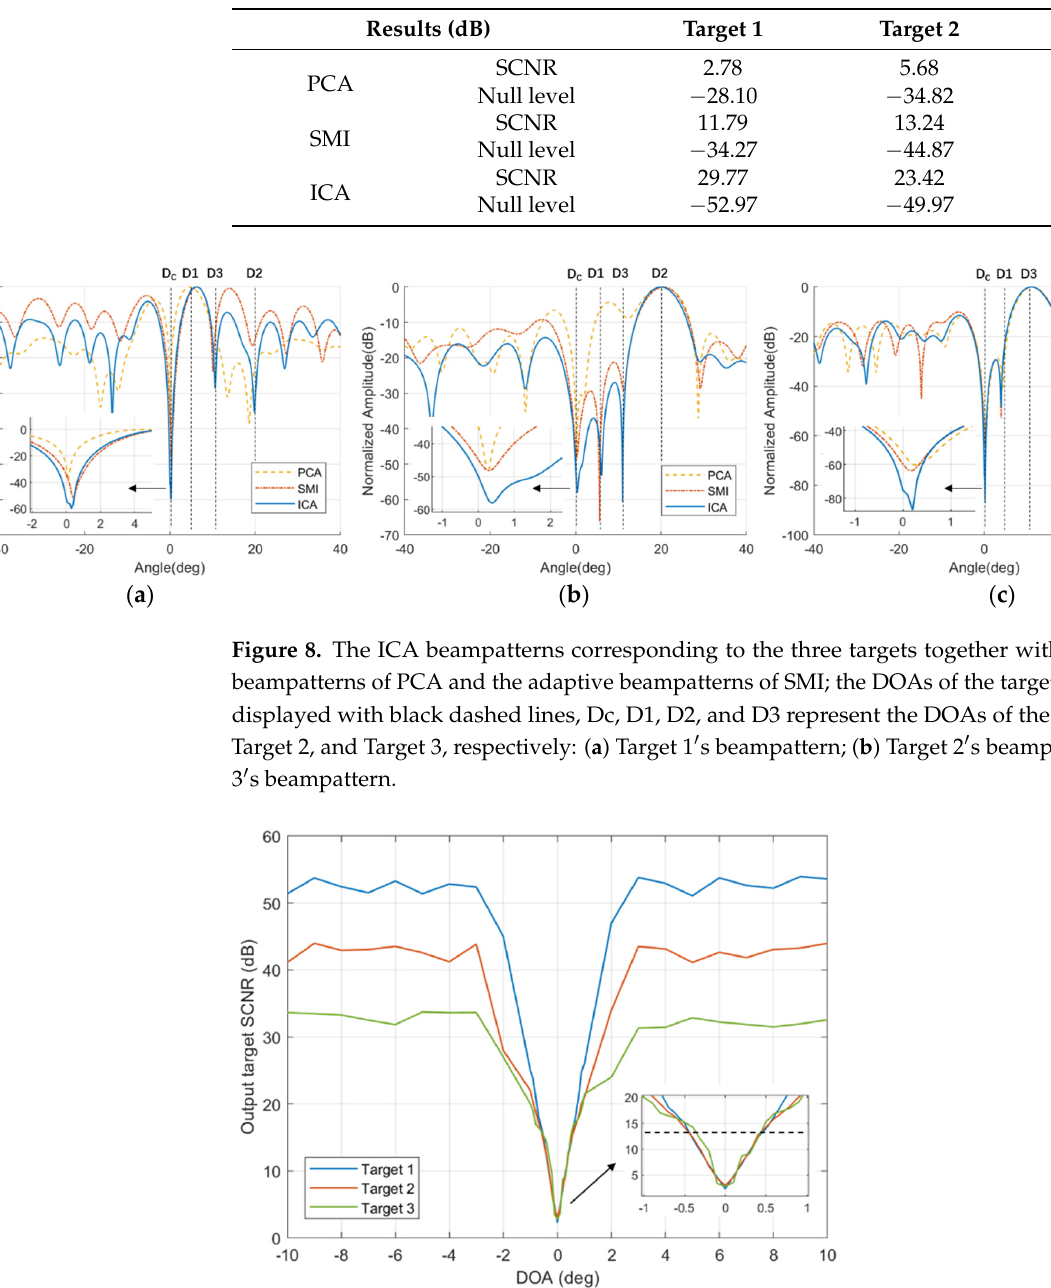
Table 4. Comparison of simulation results.